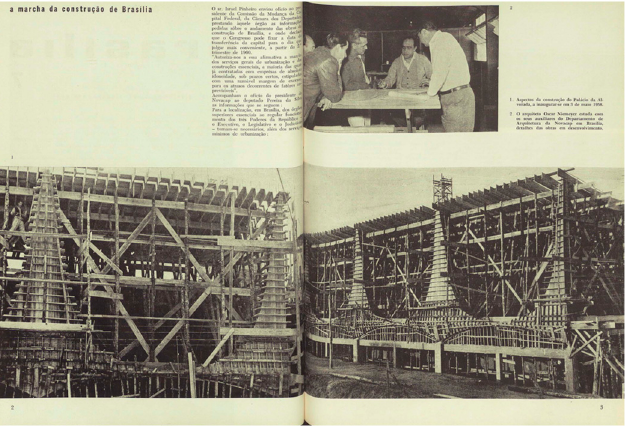
Figure 10. Column “A Marcha da Construção de Brasília,” Revista Brasília , ano 1, n. 7, 1957, courtesy of Arquivo Público do Distrito Federal.